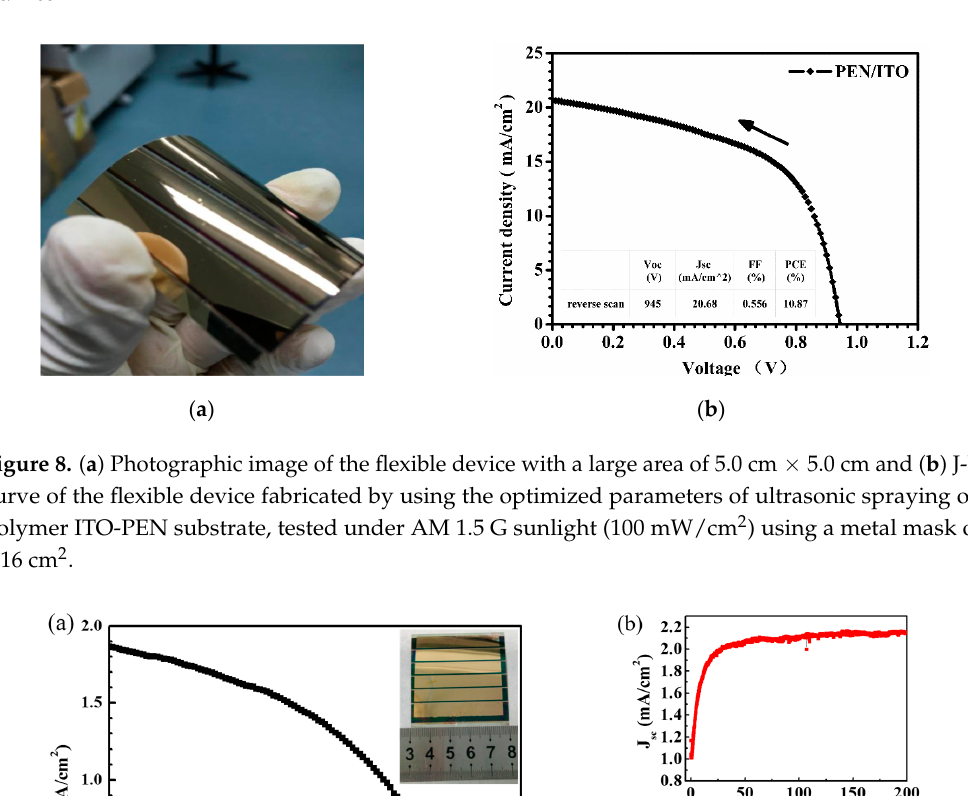
Figure 7. Long-duration stability test of a typical PSC based on ITO-glass, measured under AM 1.5 G sunlight (100 mW/cm 2 ) using a metal mask of 0.16 cm 2 . ( a ) J-V curve of the PSC; and ( b ) FF, PCE, J sc , V oc . Micromachines 2017 , 8 , 55